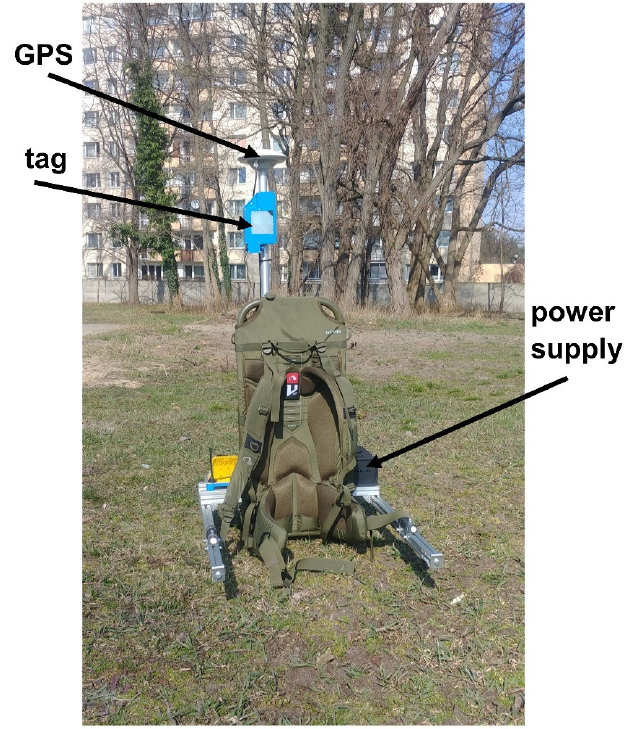
Figure 3. Mobile UWB guide location